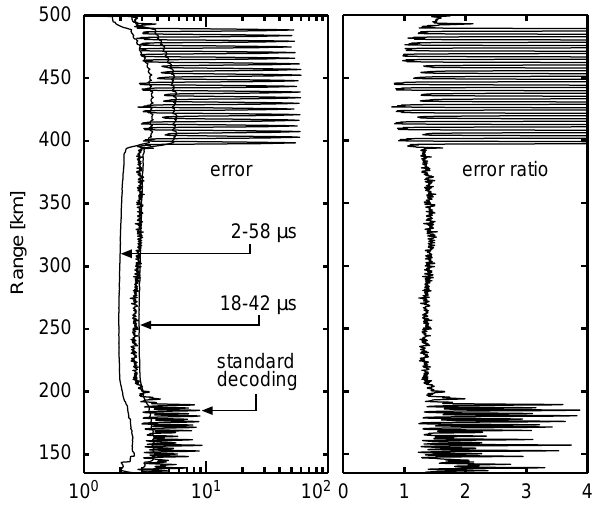
Fig. 8. Left: The range profile of the 30- µ s lag for the modulation in Fig. 3 with standard decoding, together with corresponding profiles obtained from the inversion method after filtering the inversion out- put according to Eq. (30). The 2–58- µ s and 18–42- µ s profiles have been shifted by 20 units to the right and left, respectively. Right: The differences of the profile given by standard decoding and the two profiles given by the inversion method.